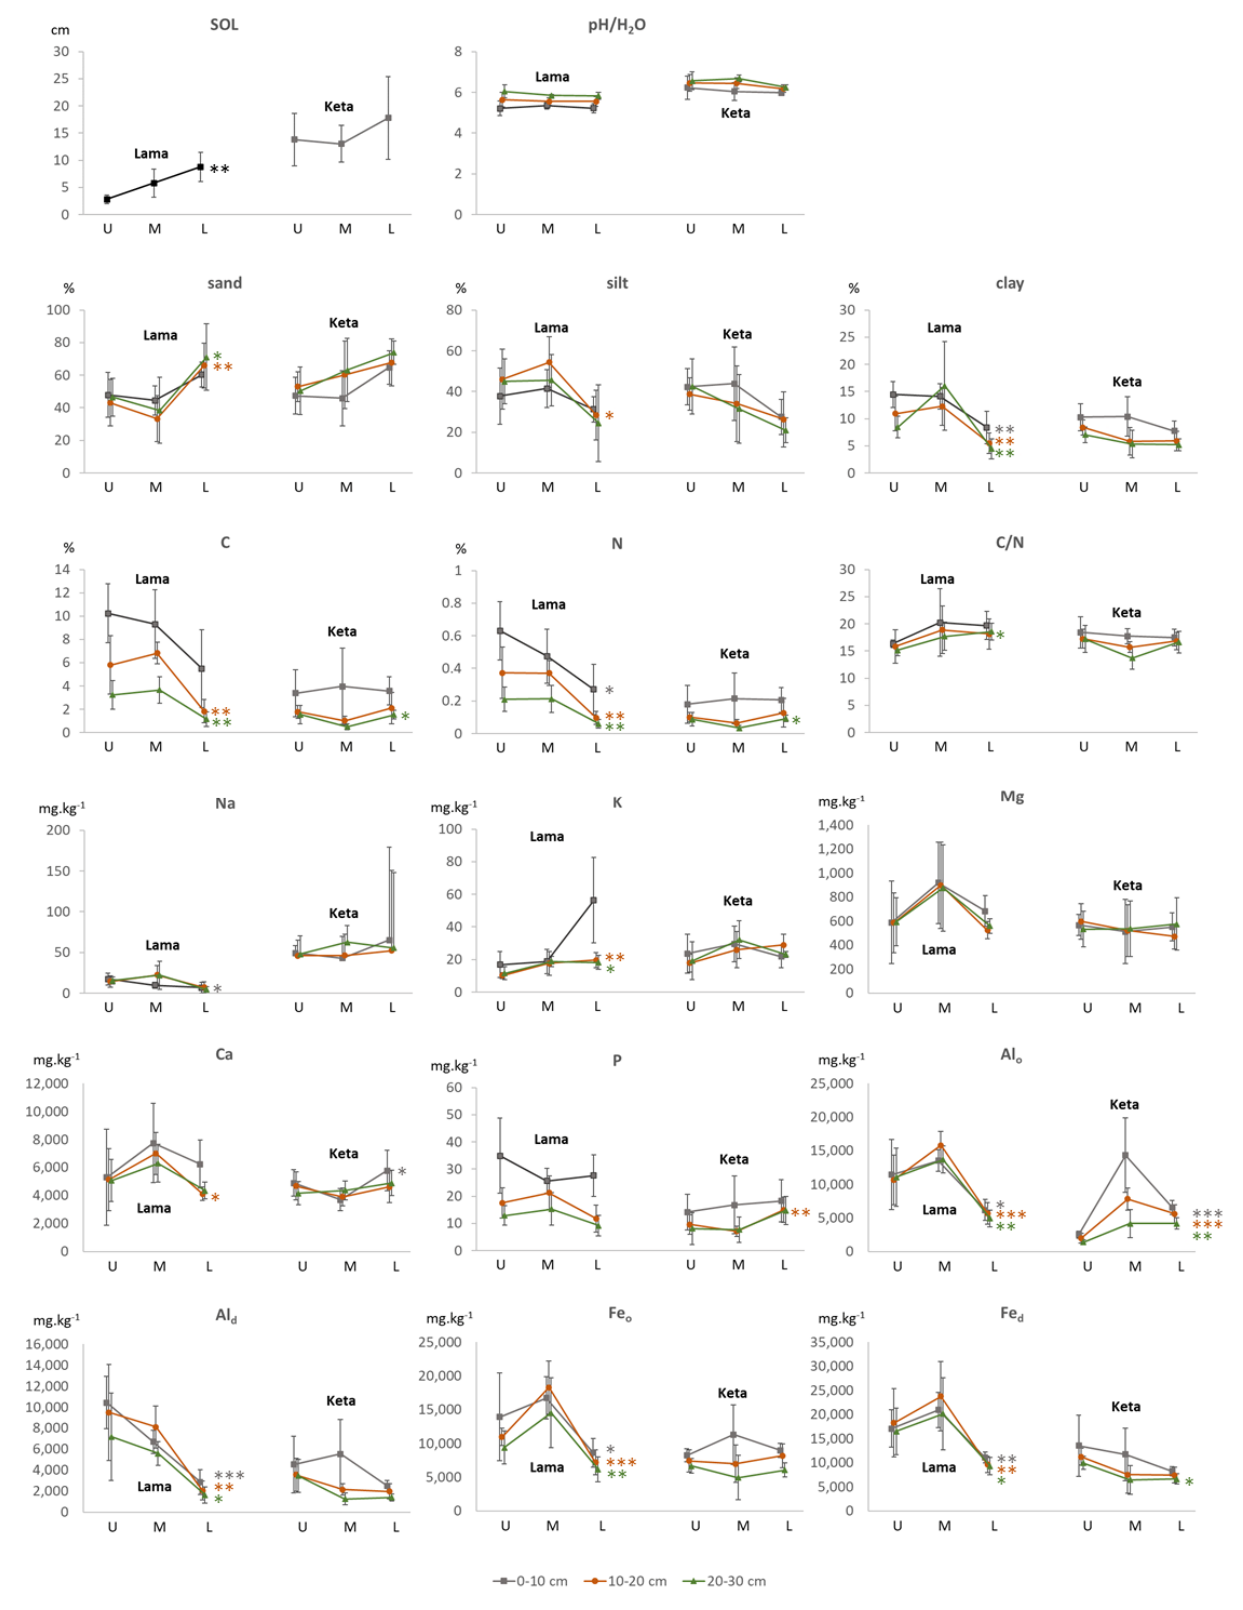
Figure 3. Changes of soil properties along the altitudinal gradient in different soil depths at the Lama and Keta localities (U–upper transect, M–middle transect, L–lower transect; vertical bars represent standard deviations). Significance of ANOVA F -tests: *** p < 0.001, ** p < 0.01, * p <